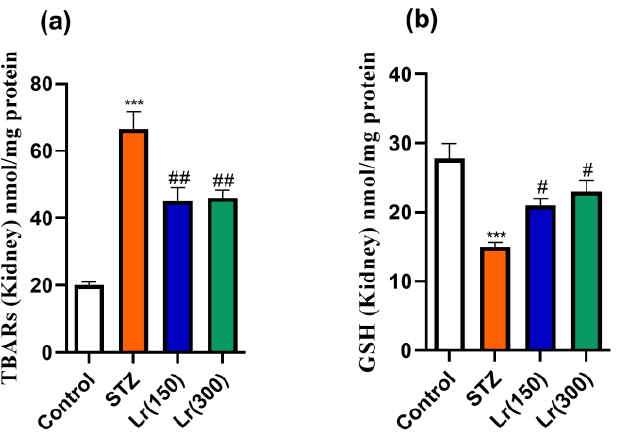
Figure 5. Effect of L. regularis (150 or 300 mg/kg for 4 consecutive weeks) on diabetic-induced changes in renal oxidative stress parameters thiobarbituric acid reaction substance (TBARS) ( a ) and glutathione (GSH) ( b ) levels. Data are expressed as means ± SE ( n = 6) and were analyzed using one-way ANOVA followed by Student Newman–Keuls as post hoc test. * Control vs. STZ group; # STZ vs. L. regularis (150) or L. regularis (300). # p < 0.05, ## p < 0.01, *** p < 0.001.